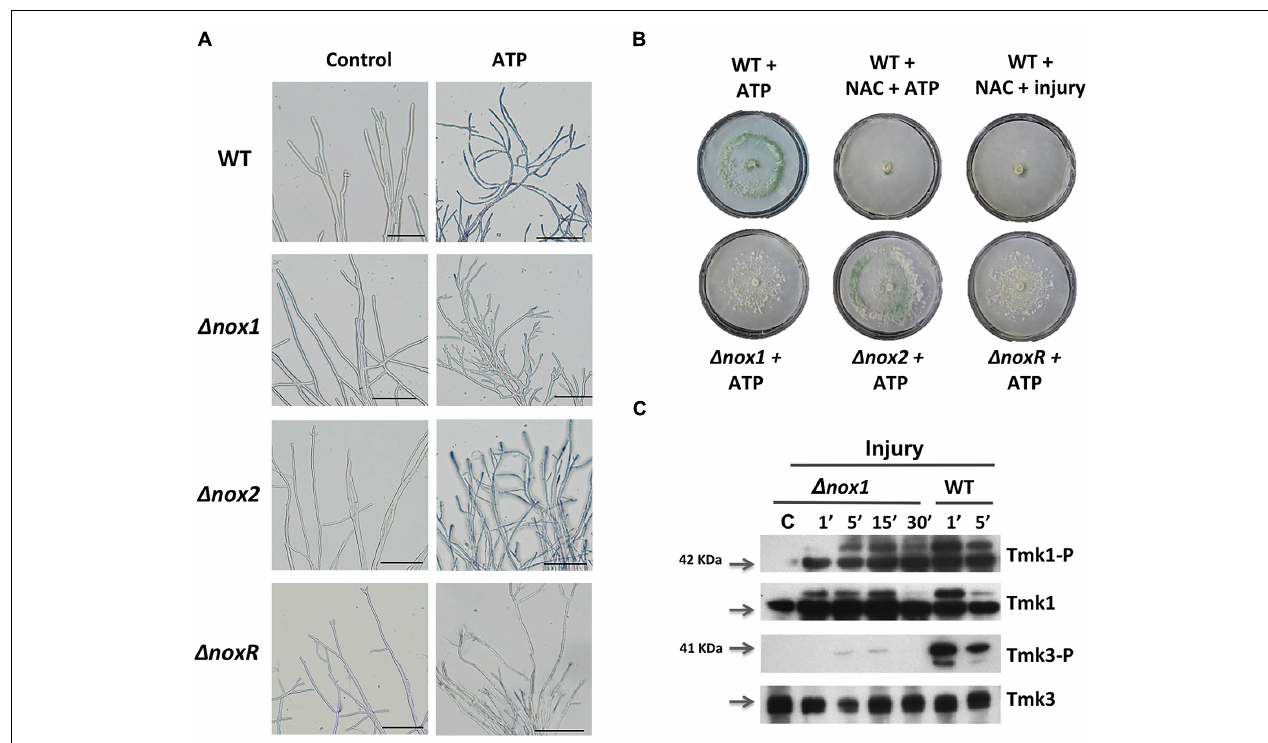
FIGURE 5 | Production of superoxide in response to extracellular ATP (eATP). (A) Detection of superoxide. WT, (cid:2) nox1, (cid:2) nox2 , and (cid:2) noxR strains were incubated with ATP (0.1 mM), followed by incubation in a 0.3 mM NBT solution and examined by bright-field microscopy (BF).The blue/purple coloration indicates the production of superoxide (formazan generation).The scale bar = 10 μ m. (B) eATP-induced conidiation.The WT strain was treated with ATP (0.1 mM), or a combination of NAC (60 mM) and ATP, or NAC and injured with a scalpel.The (cid:2) nox1, (cid:2) nox2 , and (cid:2) noxR mutants were